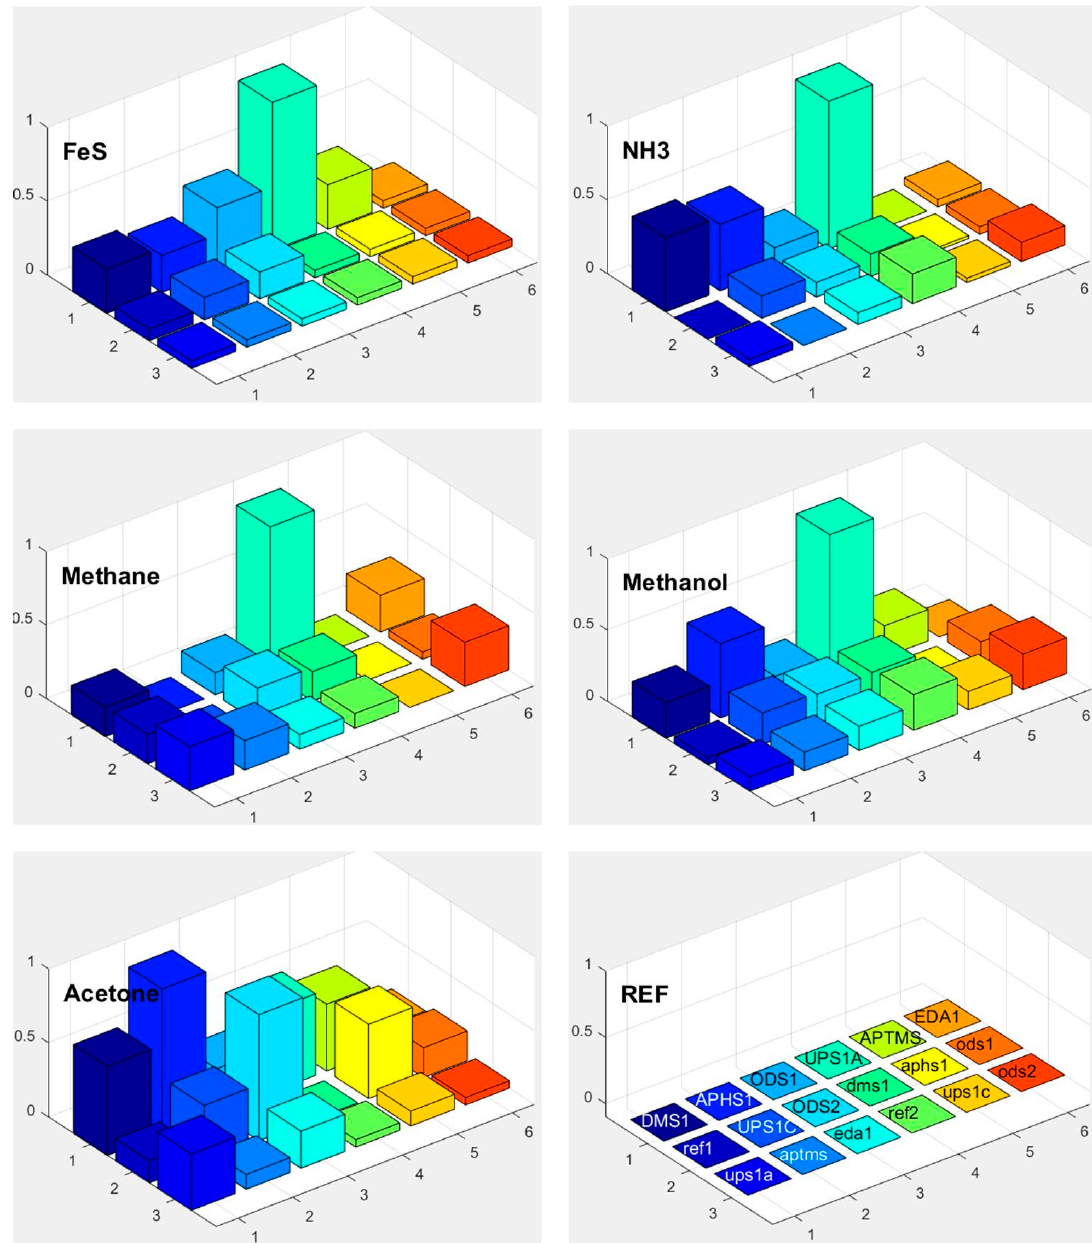
Figure 16. Responses of differently functionalized sensors to vapours of different molecules: FeS, NH 3 , methane, methanol, and acetone. The electronic response of a given sensor was normalized to the response of the sensor UPS1A. The position in the array and the colours of individual pixels shows differently functionalised sensors. The type of the functionalisation layer is printed in the array at the lower right corner (upper case names, for example DMS1, correspond to the active sensor while the lower-case names correspond to reference sensors, where functionalized layer is removed on both parts of differential sensor).